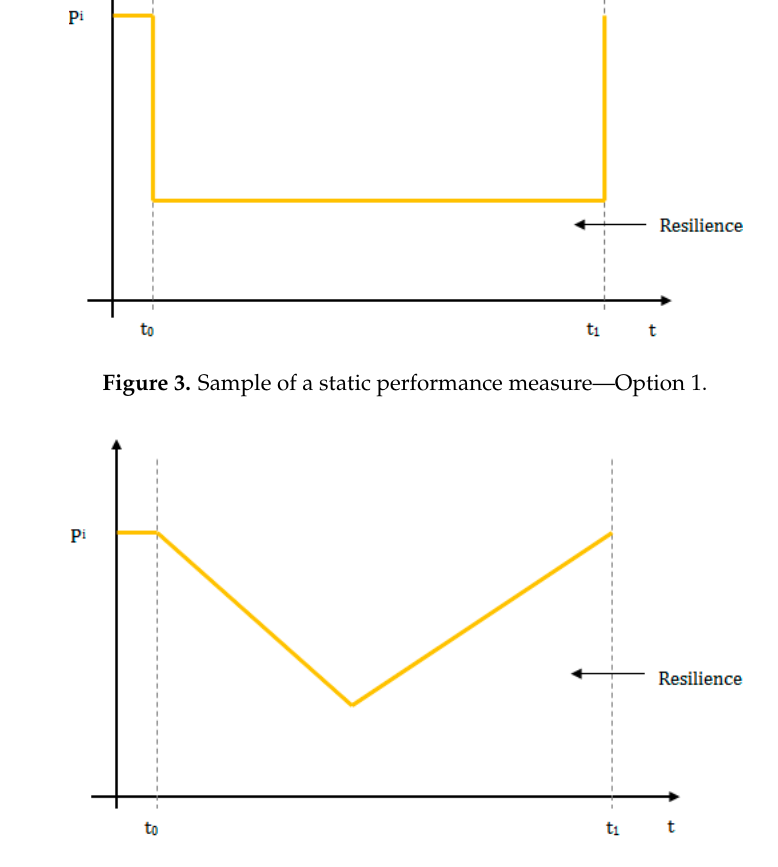
Figure 4. Sample of static performance measure—Option 2.